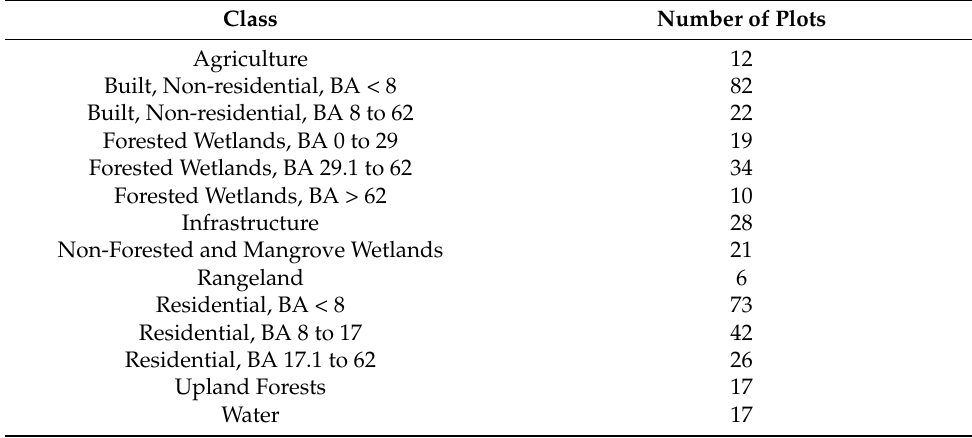
Figure 8. Pruned RPART decision tree with final bins and decision splits based on BA m 2 plot − 1 . The top number in each box shows the mean AGTC kg for the n plots in that box. The percentage reflects the number of plots in each box. Table 8. Final classification combining AGTC classification with BA classification. BA values are shown scaled (m 2 ha − 1